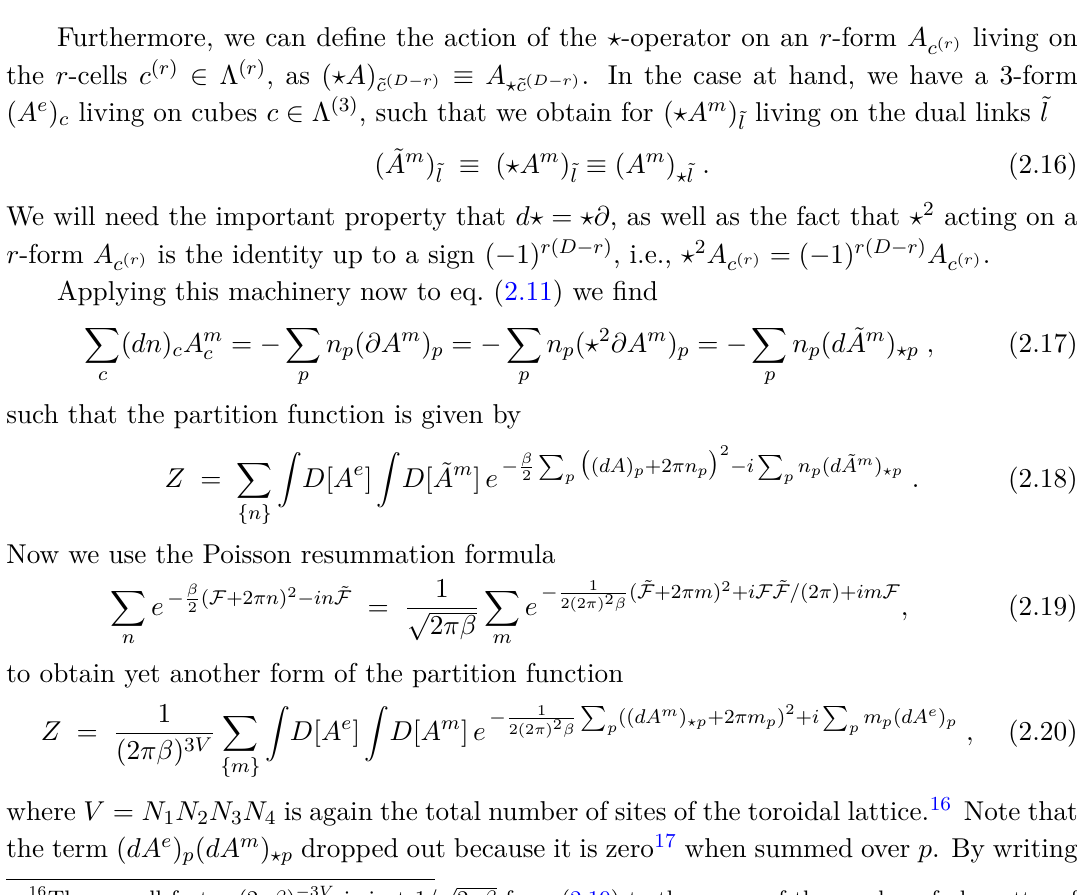
Figure 1 . Examples for the action of the ? -operator in 2d (left) and 3d